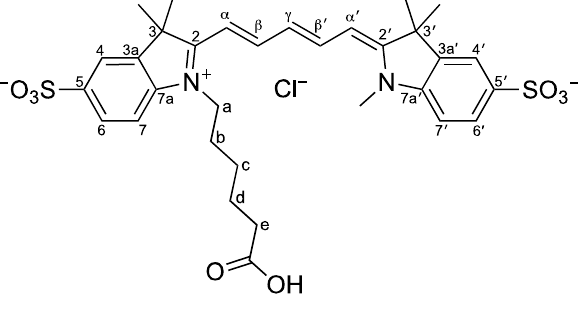
Figure 4. Structure of dye 4 .